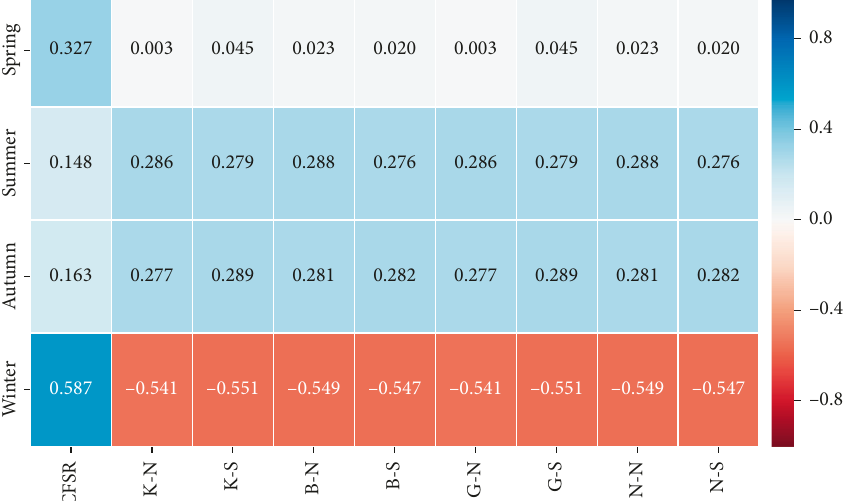
Figure 10: Pattern correlations of sensible heat fluxes between CFS reforecasts, the WRF model, and ERA-5 reanalysis for the period of 1999–2010.